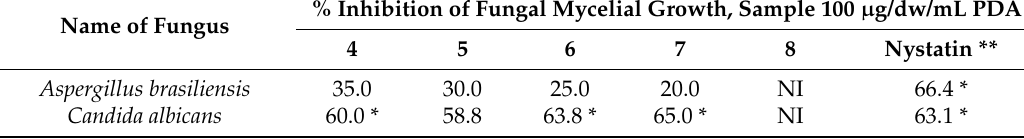
Table 4. Antifungal activities due to the rhamnopyranoside derivatives 4 – 8